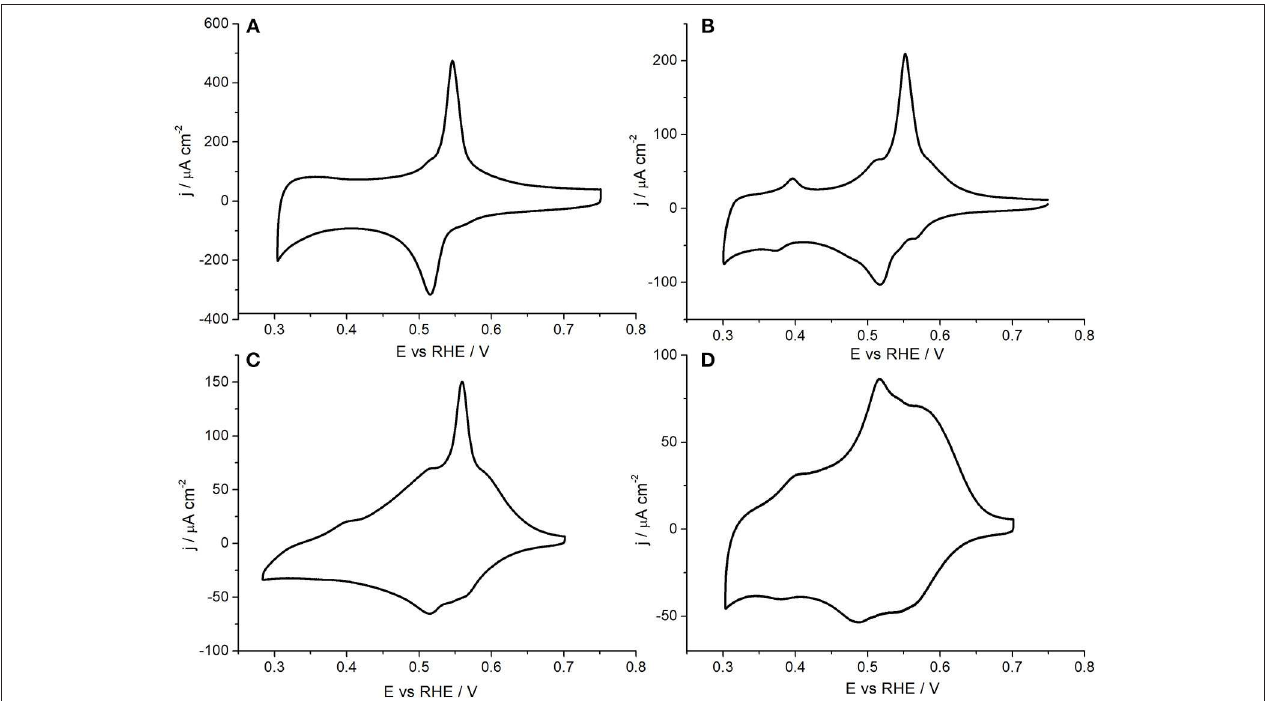
FIGURE 7 | Cu UPD voltammograms obtained with (A) Pd Cub , (B) Pd 20 Cub , (C) Pd 10 Cub , and (D) Pd 3 Sp nanoparticles. Test solution 0.1M H 2 SO 4 + 1mM Cu 2 + + 1mM NaCl, scan rate 50mV s − 1 .